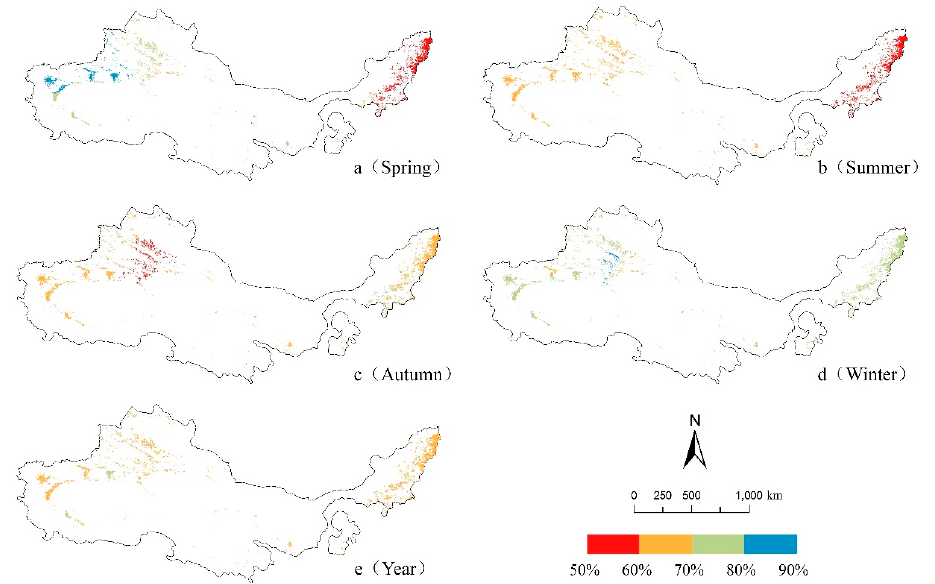
Figure 2. Interpolation of the annual relative soil moisture of farmland in inland river basin areas during 1992–2011.